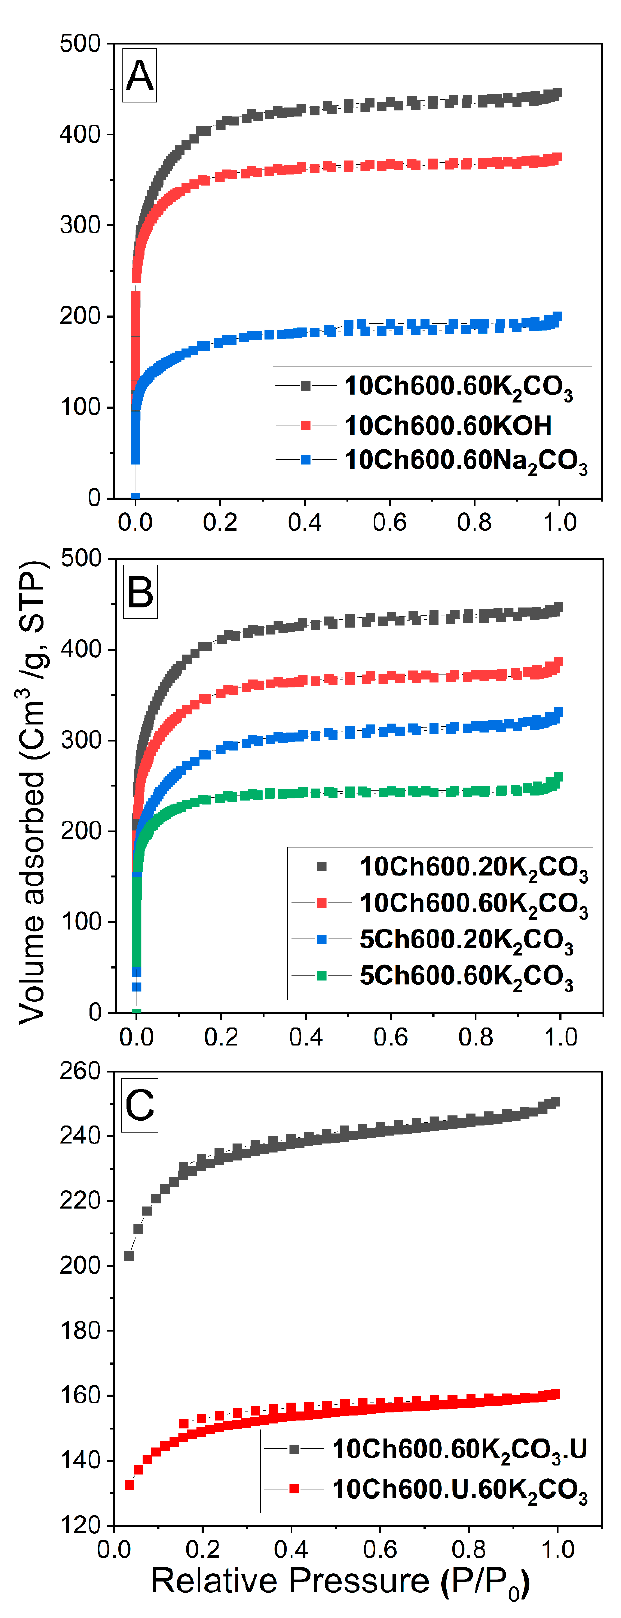
Figure 1. N 2 adsorption-desorption isotherms ( A ) for Ch-AC with different activators, ( B ) for Ch- AC using K 2 CO 3 as activator with different amount of activator and chitosan, and ( C ) for Ch-AC prepared with post- and pretreatment method using urea (U).